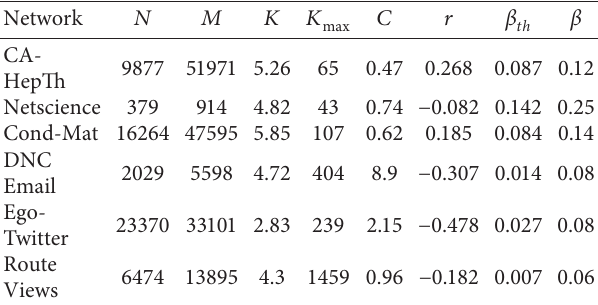
Table 2: The basic topological features of four real network